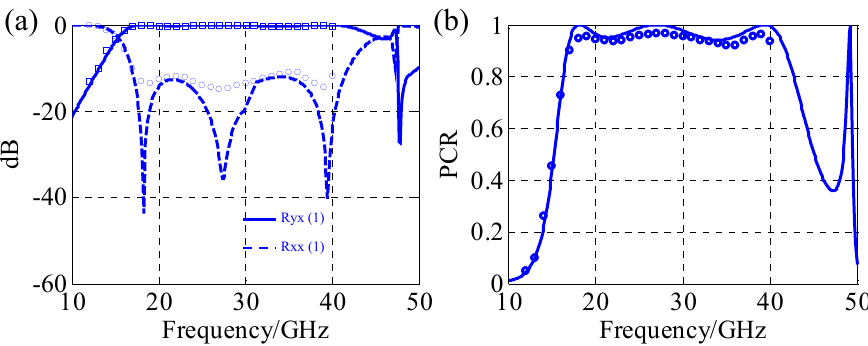
Figure 8. Comparison between measurement and simulation. ( a ) Rxx and Ryx ; ( b ) PCR. Measurement was conducted at 20°. Table 2. A performance comparison of reflective polarization rotators presented in literature.